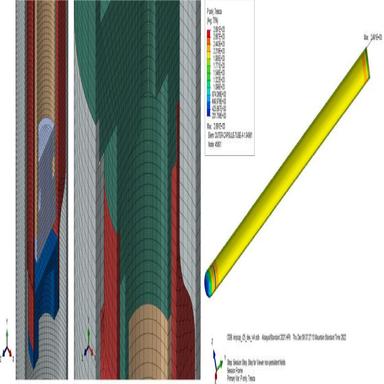
Shows axial cross section views of the IMPACT capsule ABAQUS model (left), and the ABAQUS Tresca stress results on the outer capsule (right).